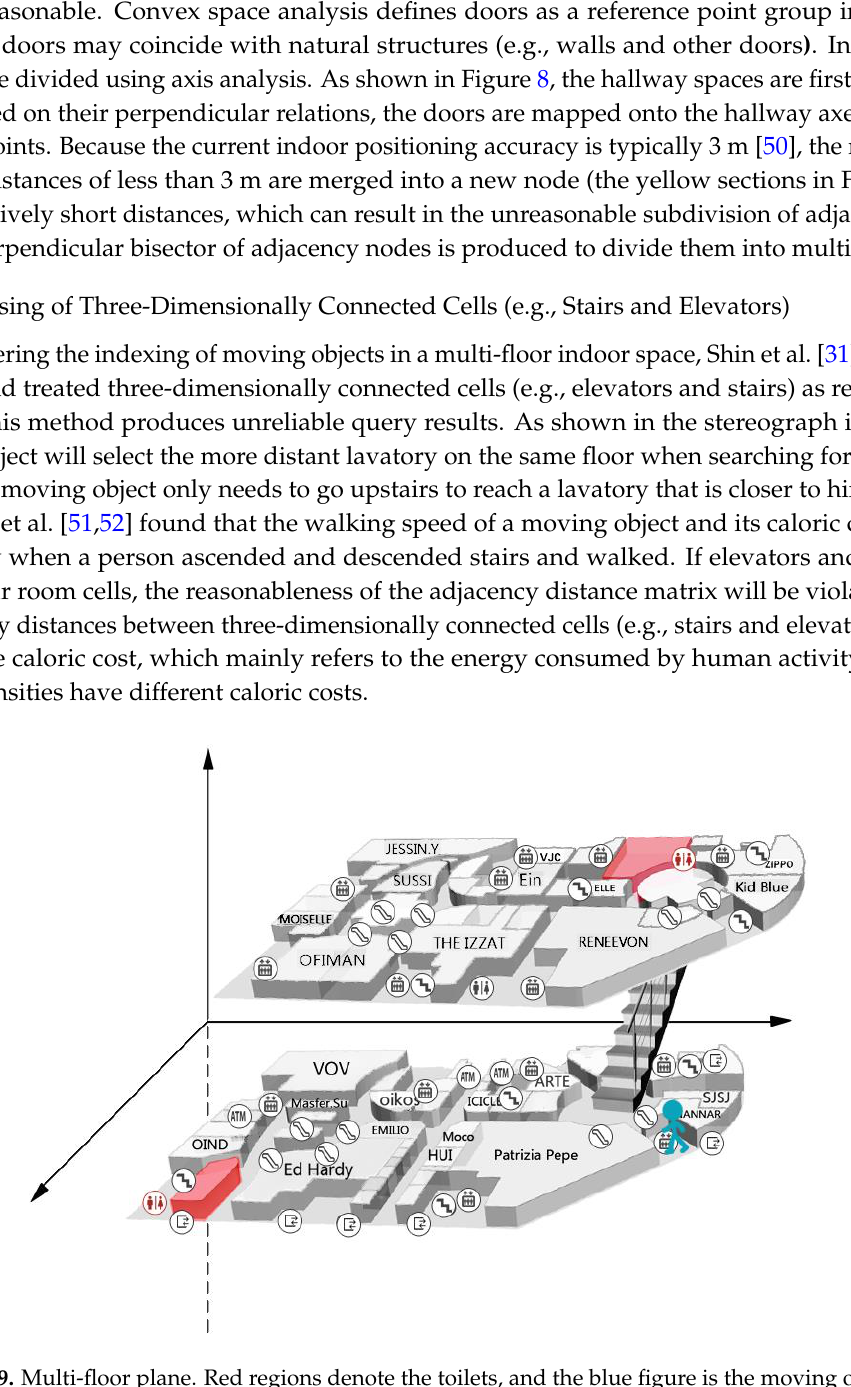
Figure 9. Multi-floor plane. Red regions denote the toilets, and the blue figure is the moving object.